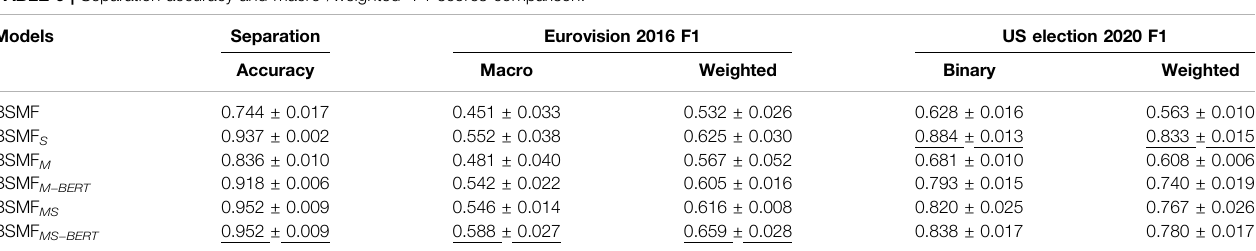
TABLE 6 | Separation accuracy and macro-/weighted- F1 scores comparison.